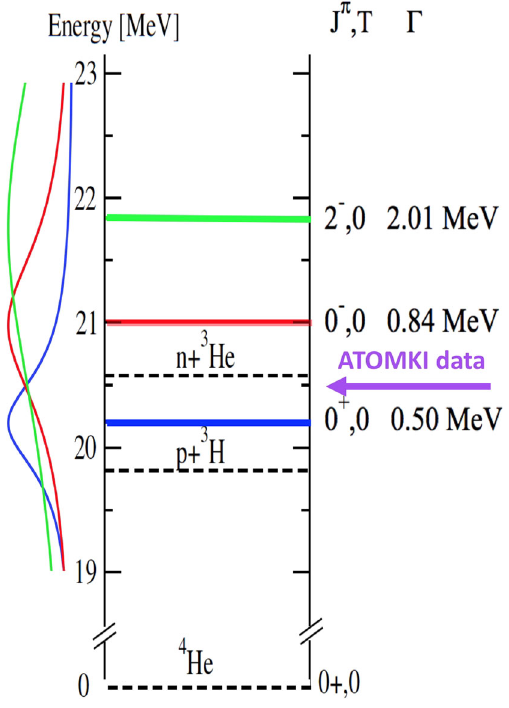
Fig. 15 Thelow-energyspectrumof 4 He.Thedashedlinesindicatethe thresholds for the opening of the 1 + 3 channels, while the solid lines indicate the energy levels of the first resonances with corresponding widths, J π , and isospin assignments to the right. Also indicated is the highest energy of the ATOMKI measurements, performed just below the threshold for the 3 He ( n , p ) 3 H reaction opening. See [67] for more